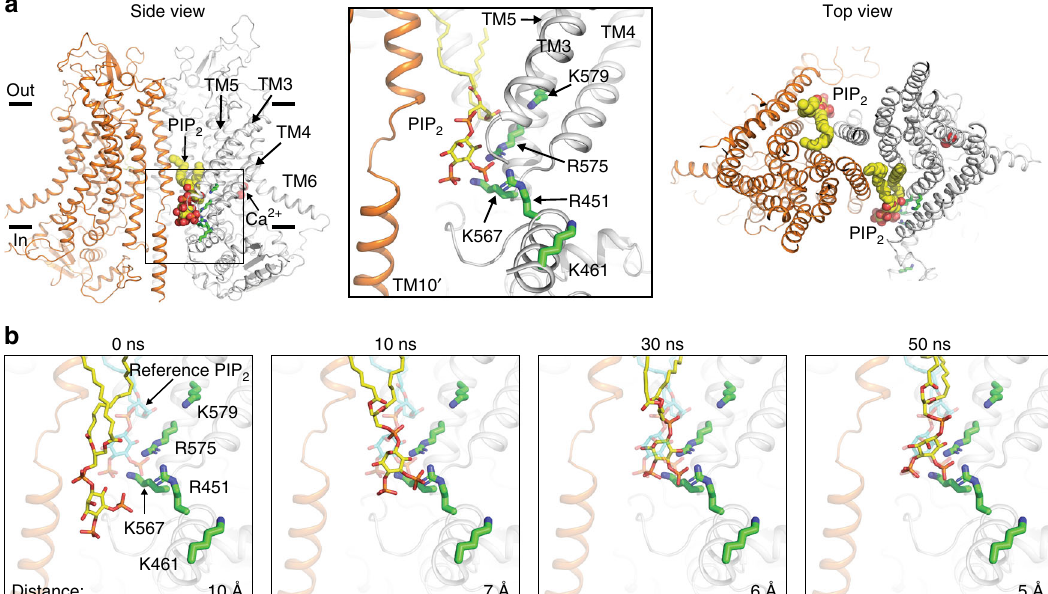
Fig. 4 Structural model of PIP 2 bound to the putative binding site of TMEM16A. a Side and top view of a representative snapshot from a 400-ns atomistic simulation of the docked complex showing two well-equilibrated PIP 2 molecules (spheres) in the binding sites. Two TMEM16A monomers are shown as cartoon in orange and gray, respectively. Close-up view showing the potential interactions between PIP 2 and the putative PIP 2 binding residues (green sticks) is on the right. b Snapshots from the fi rst 50 ns of a 200-ns atomistic simulation (see Supplementary Video 1) showing the process of a free PIP 2 molecule binding spontaneously to the same site in a con fi guration highly similar to the one obtained through docking followed by equilibration using atomistic simulations (shown as the “ reference PIP 2 ” position in cyan sticks in all snapshots). The protein is shown as transparent cartoon, with four main PIP 2 -contacting residues (R451, K567, R575, and K579) and the free PIP 2 molecule shown in green and yellow sticks, respectively. R482 is not shown as it is part of the highly fl exible TM2 – 3 loop that was modeled into the structure. TM10 from the adjacent monomer is in orange. Note that PIP 2 remained in a similar bound con fi guration after 50 ns for the rest of the simulation. The distances between the centers of mass of PIP 2 and the key residues are also shown in the lower right of each